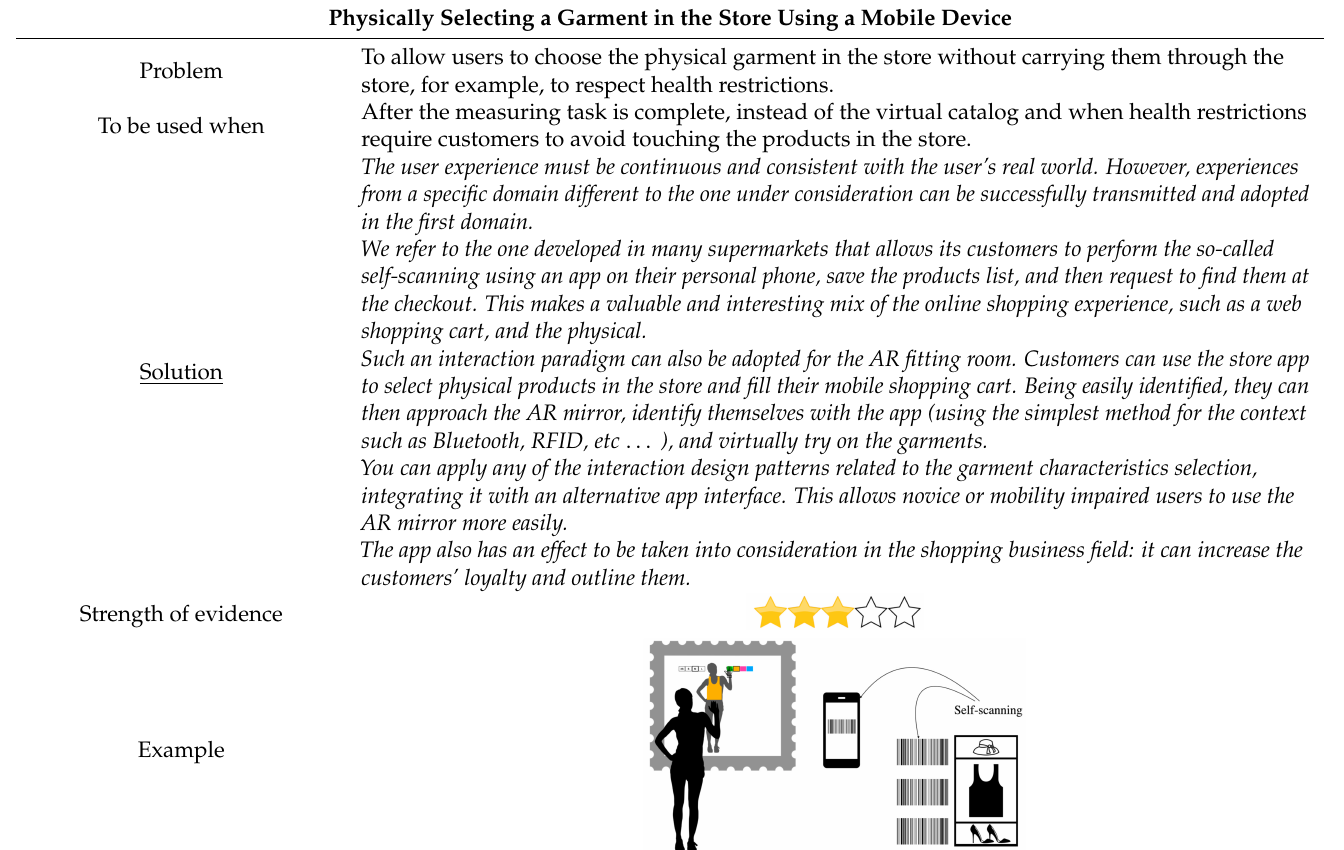
Table 10. Physically selecting a garment in the store using a mobile